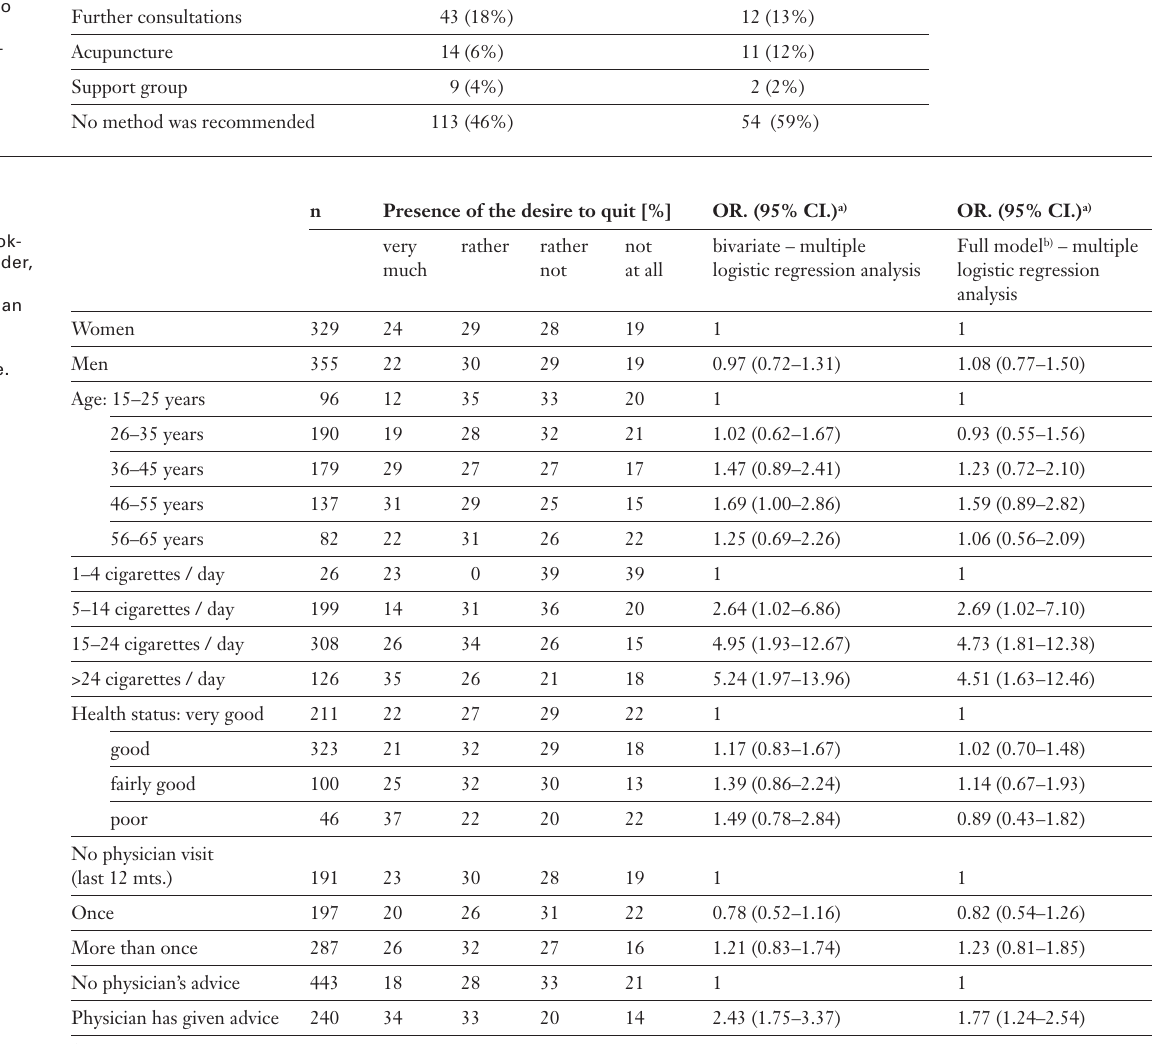
Which methods are recommended by physicians (n = 337, persons advised to quit; multiple an- swers; every cate- gory has been probed)?